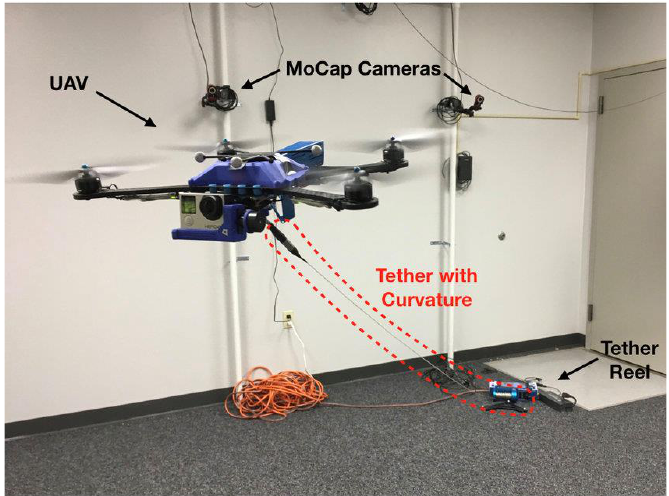
Figure 2. UAV flying in a motion capture studio with a tether dragged down by gravity